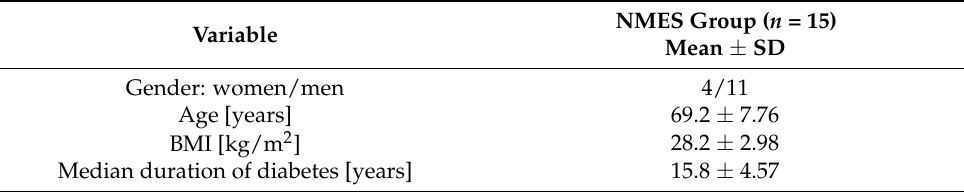
Table 2. Patients’ characteristics at baseline ( n = 15).